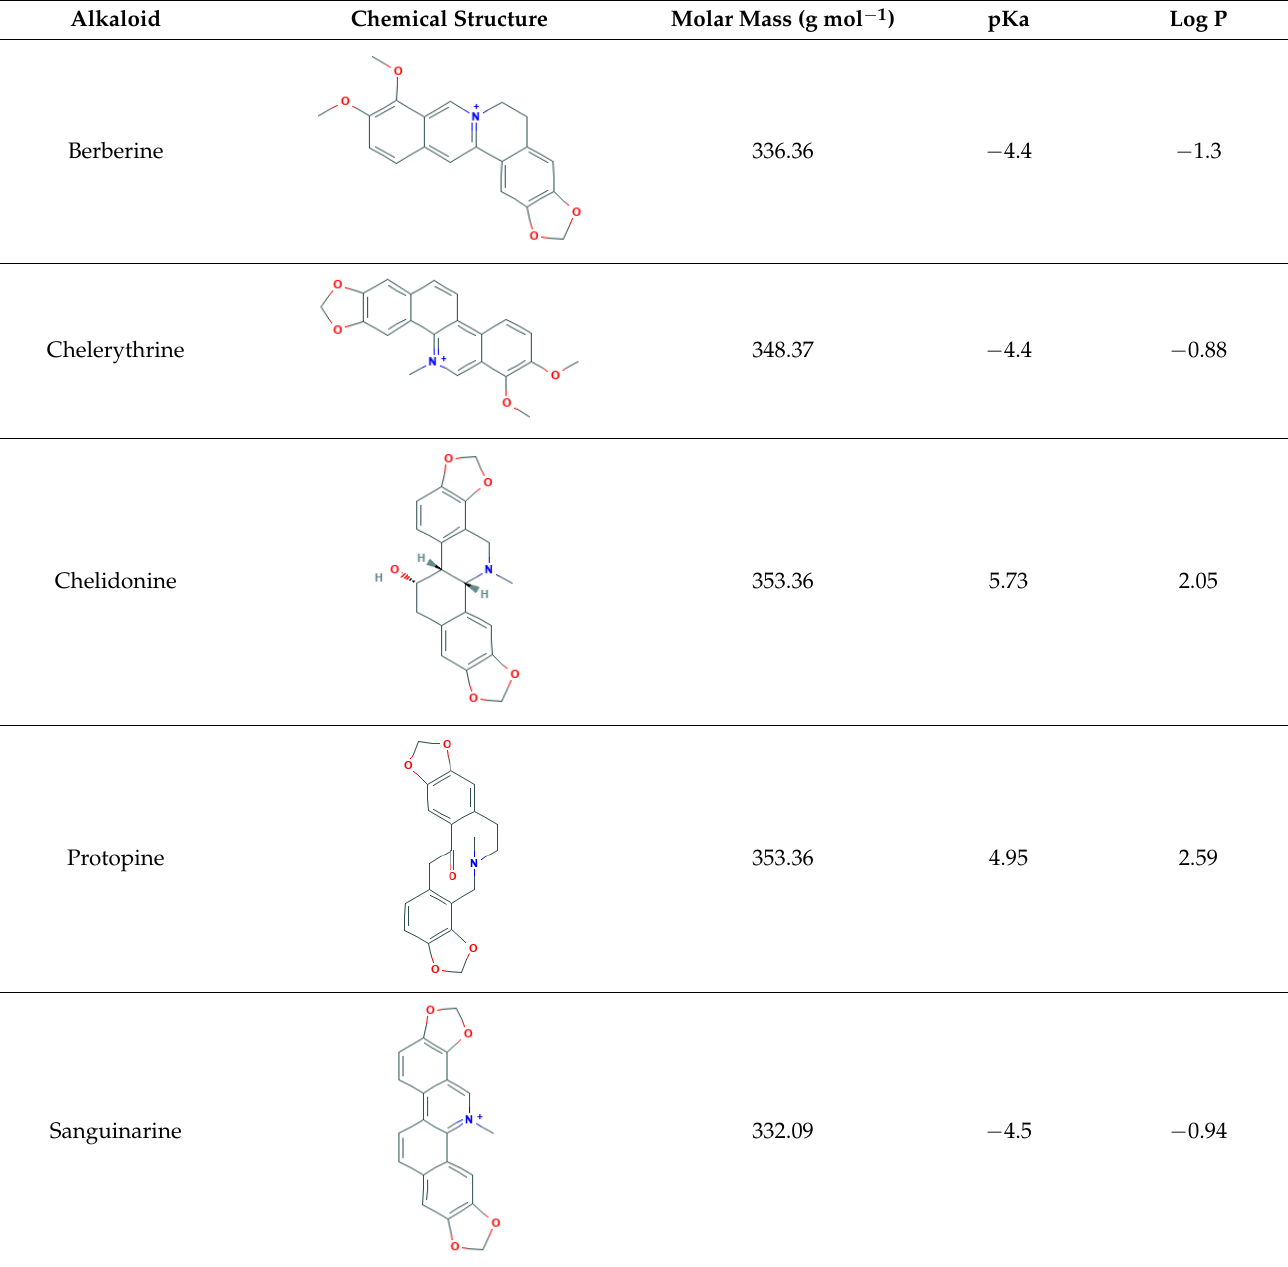
Table 1. Physicochemical properties of the selected